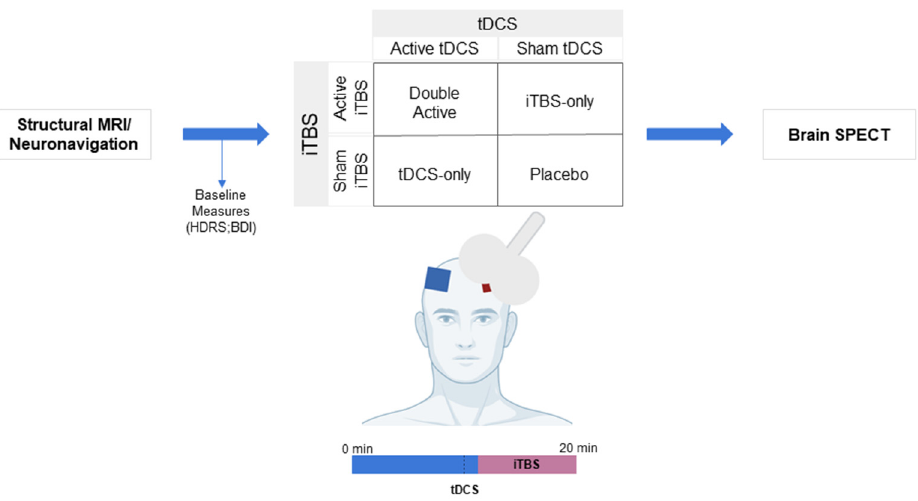
Figure 1. Study design. Structural MRI and the neuronavigation were performed in the first session. Afterwards, participants underwent four different NIBS sessions on different days. TDCS and iTBS (active or sham) were applied simultaneously in all sessions. Abbreviations: BDI: Beck Depression Inventory; HDRS: Hamilton Depression Rating Scale; iTBS: Intermittent theta-burst stimulation; min: minutes; MRI: magnetic resonance imaging; SPECT: Single-Photon Emission Computed Tomography; tDCS: transcranial direct current stimulation.